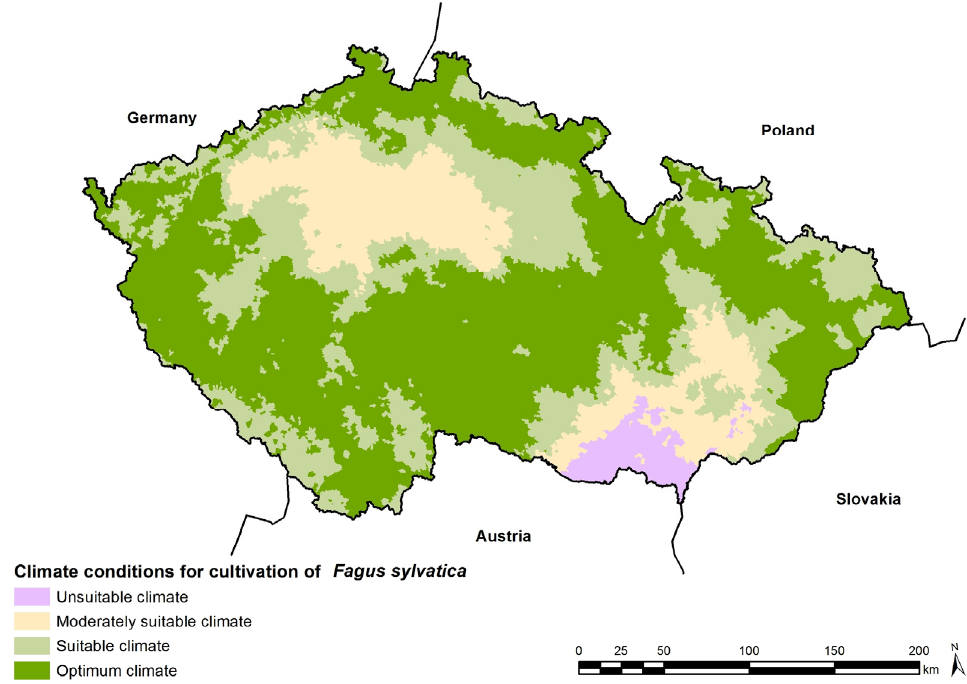
Figure 4. Visualization of predicted distribution of climate conditions for the European beech in the Czech Republic in 2050.